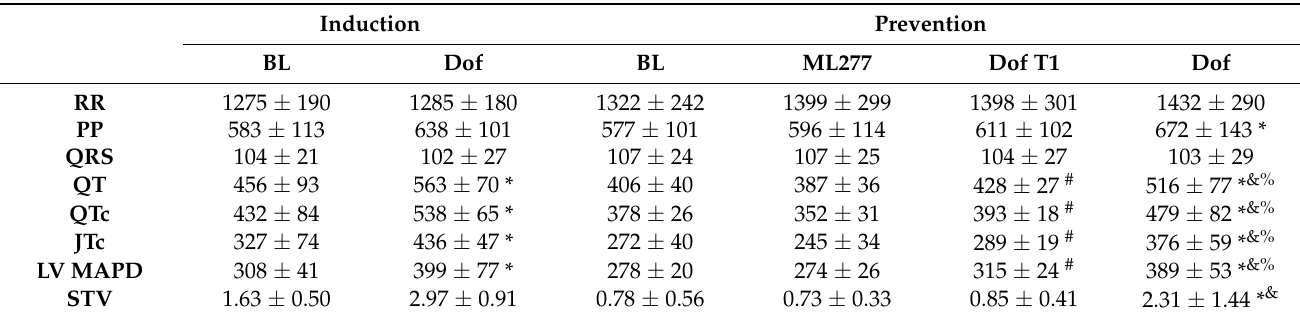
Table 1. Electrophysiological parameters from seven chronic AV block (CAVB) dogs after dofetilide (Dof), and after ML277 followed by Dof.